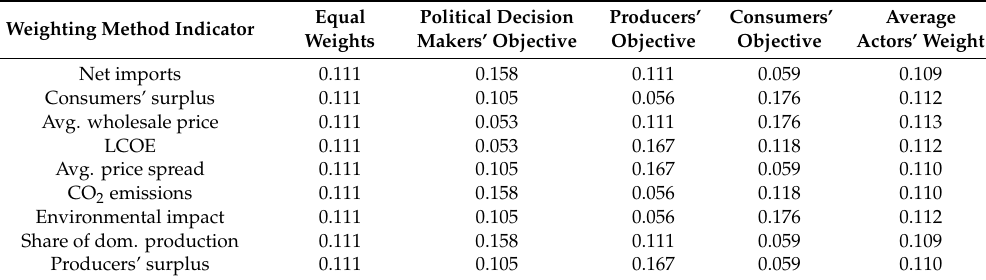
Table 8. Sets for di ff erent weighting factors. Source: Own